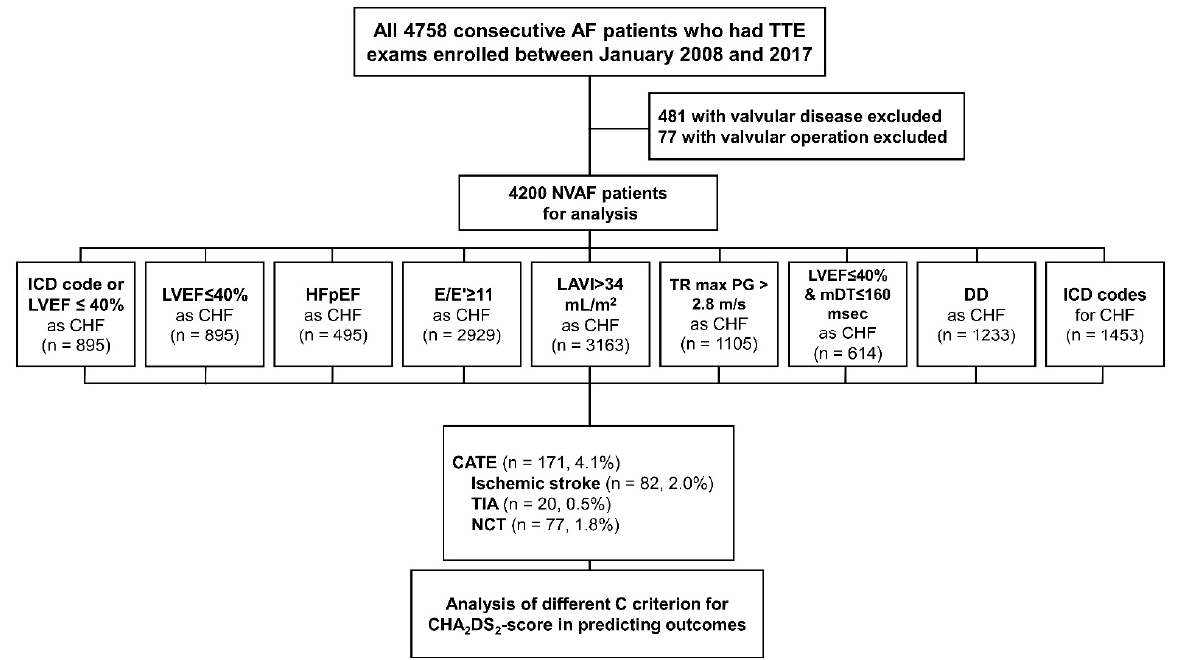
Figure 1. Diagram for enrollment: After the exclusion of 558 patients with valvular diseases, 4200 nonvalvular atrial fibrillation patients were analyzed. Multiple definitions including the original criteria were subjected were analyzed through multivariate Cox regression analysis for CATE. AF, atrial fibrillation; TTE, transthoracic echocardiography; NVAF, nonvalvular atrial fibrillation; NCT, non-cerebral thromboembolism. Other abbreviations are listed in Table 1.